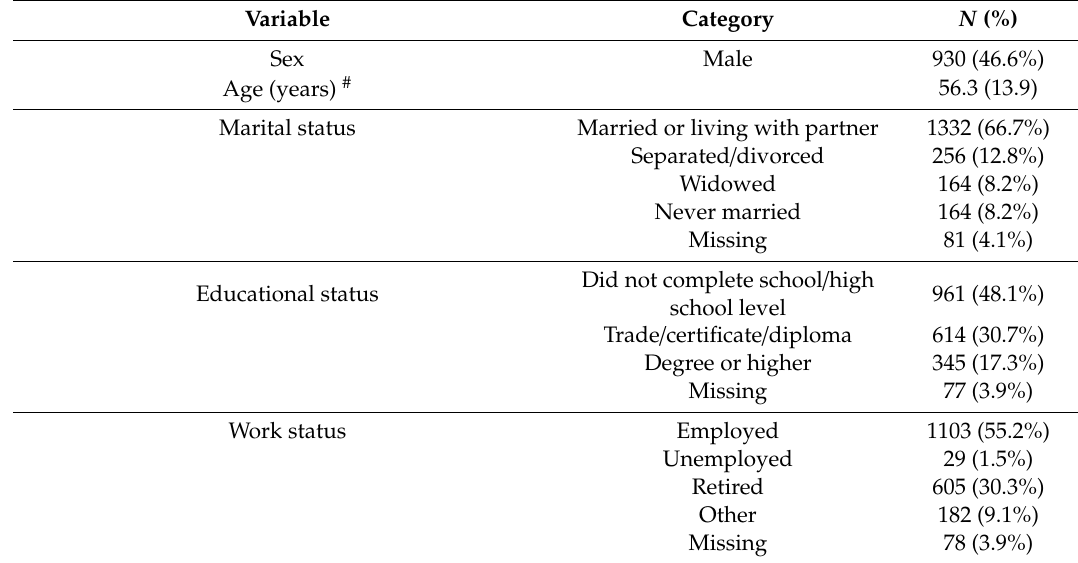
Table 1. Characteristics of study participants ( N =